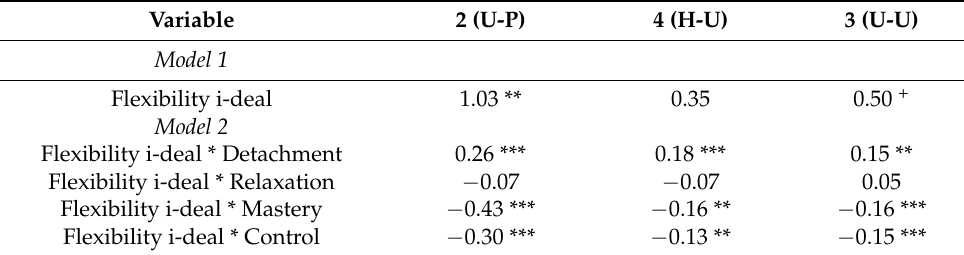
Table 2. Regression coefficients of i-deal moderated by recovery on Meaning of Work and Job Performance clusters (Study 1; N = 386).